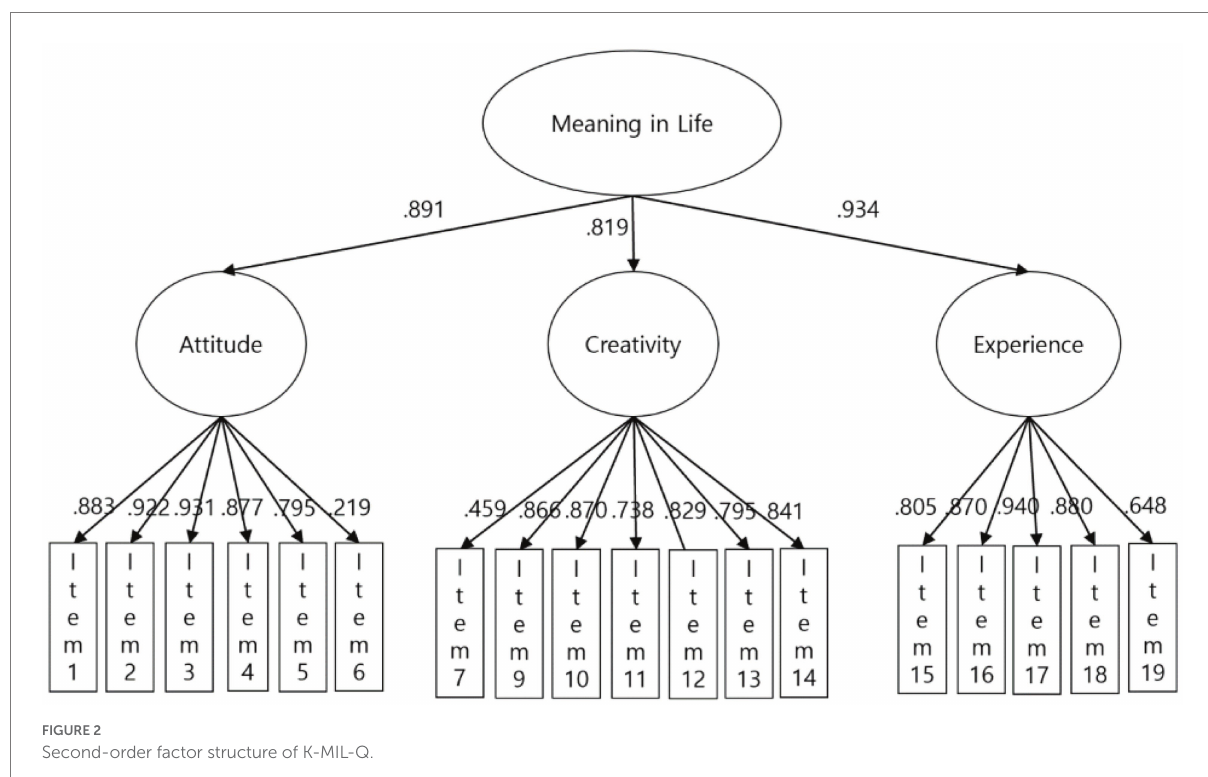
FIGURE 2 Second-order factor structure of